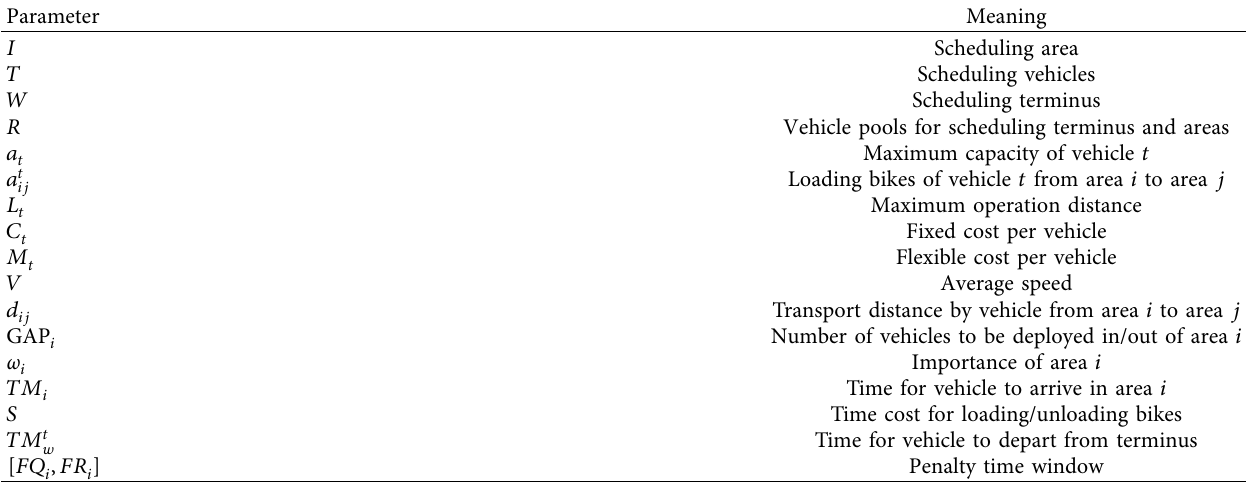
Table 2: Te meaning of parameters for formulations 1–14.